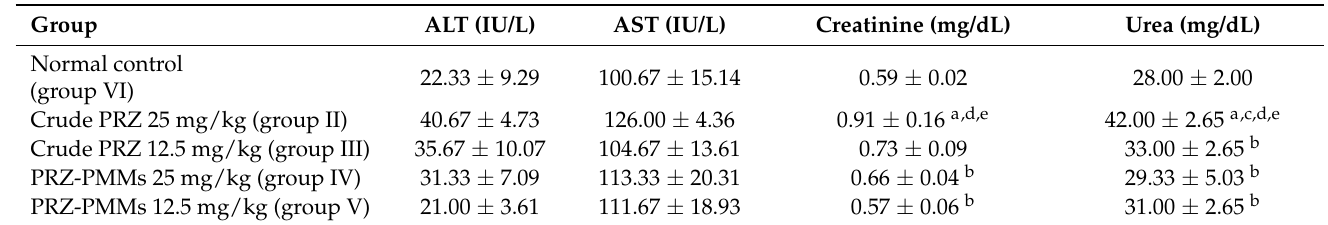
Table 9. The effect of crude PRZ and PRZ-PMMs on liver and kidney functions in different stud- ied